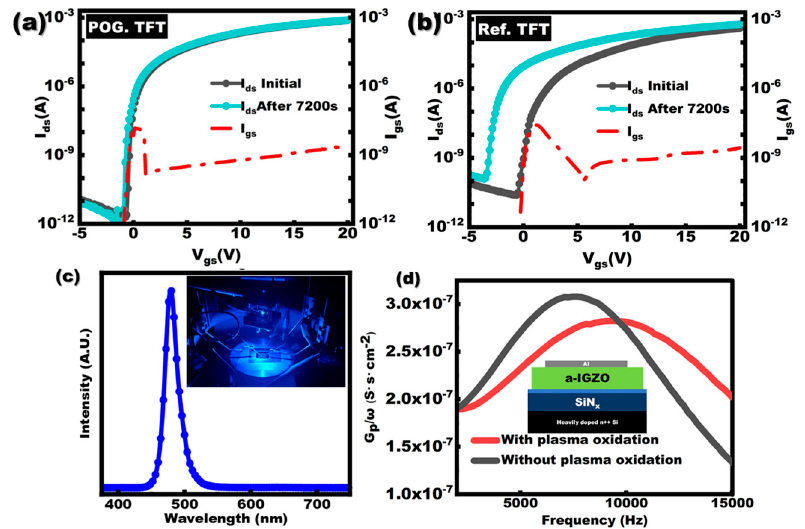
Figure 5. The curves of transfer characteristic before/after NBIS test for ( a ) Ref. TFT and ( b ) POG. TFT; ( c ) spectrum of blue LED used in NBIS test; ( d ) G p / ω as the function of frequency for Ref. and POG. MOS capacitor.